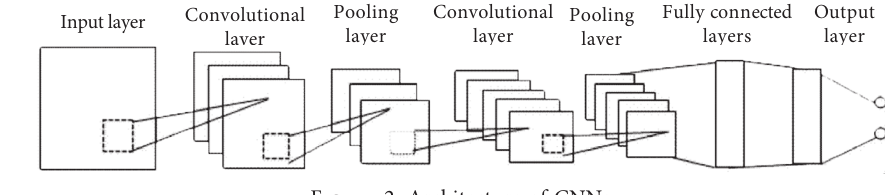
Figure 2: Architecture of CNNs.